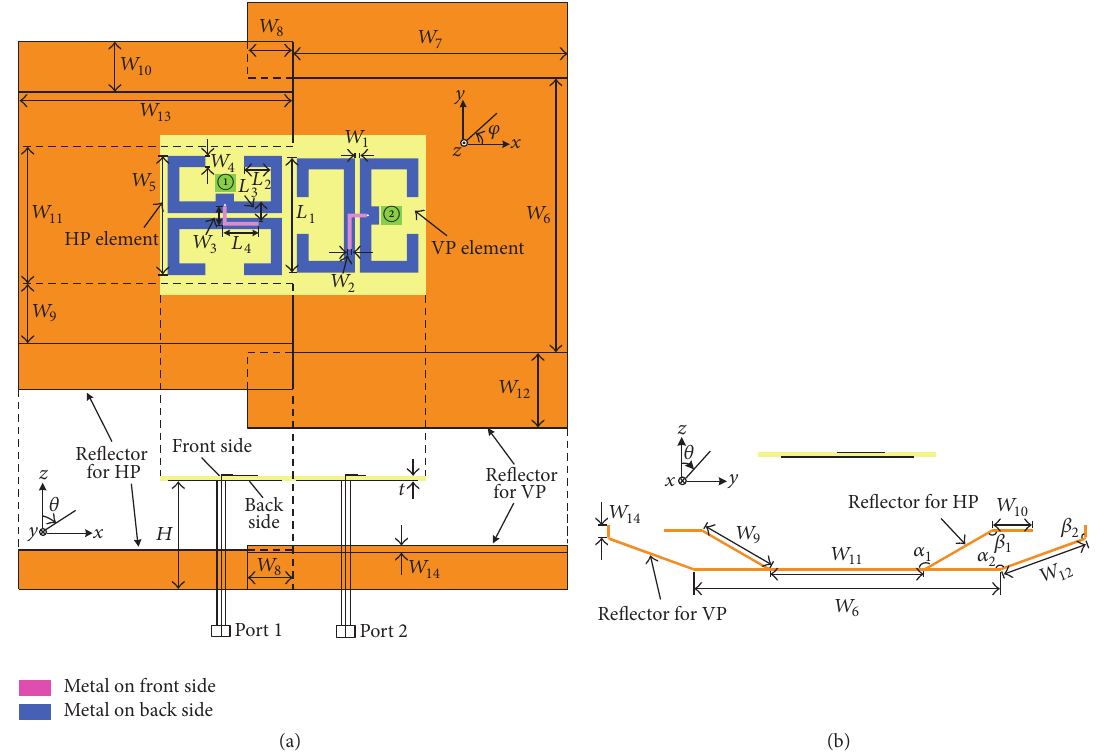
Figure 1: Configuration of a broadband V/H dual-polarized antenna: (a) top view; (b) side view.